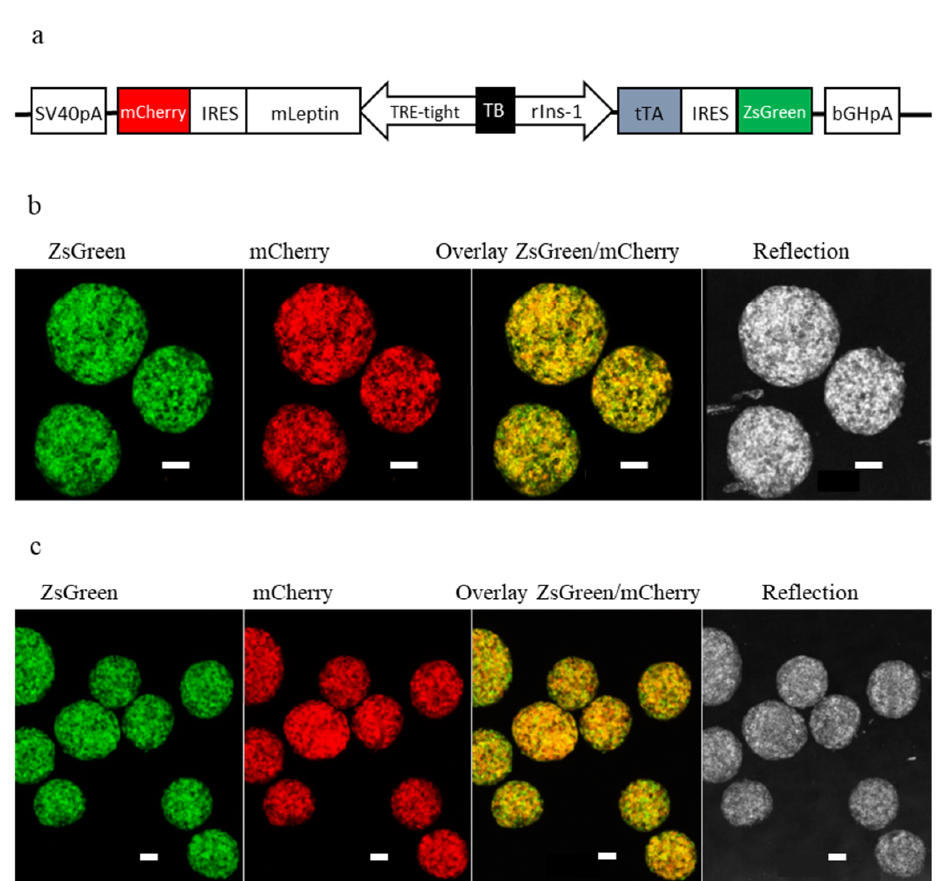
Figure 1. In vitro characterization of leptin-expressing islet organoids. ( a ) Schematic illustration of vAd-RIP-leptin-OFF. The rat insulin-1 promoter (rIns-1) drives expression of the synthetic transcription factor tTA and the green fluorescent protein ZsGreen in pancreatic beta-cells. The TRE-tight promoter drives expression of mouse leptin (mLeptin) and the red fluorescent protein mCherry. The two expression cassettes are separated by a transcription blocker sequence (TB). Binding of tTA to the TRE-tight promoter induces in the absence of doxycycline the expression of leptin and mCherry, while addition of doxycycline turns-off the expression of the two proteins. IRES-elements in the cassettes ensures stoichiometric expression of the two proteins under the same promoter. ( b ) Representative maximum projection of a 3D-stack of leptin-expressing islet organoids, obtained by confocal imaging, cultured for 4 weeks in vitro (1st set of experiments), showing reflection, expression of ZsGreen, mCherry and their overlay. Scale bar: 50 µm. ( c ) Representative maximum projection of a 3D-stack of leptin-expressing islet organoids, obtained by confocal imaging, cultured for 4 weeks in vitro (2nd set of experiments), showing reflection, expression of ZsGreen, mCherry and their overlay. Scale bar: 50 µm.